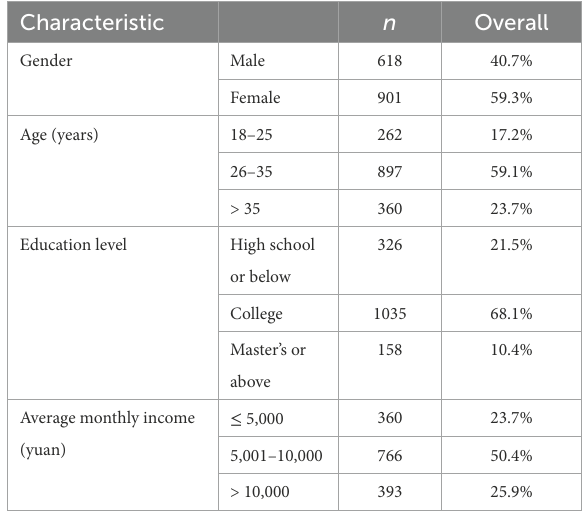
TABLE 2 Characteristics of participants in Study 2 ( N = 1,519).